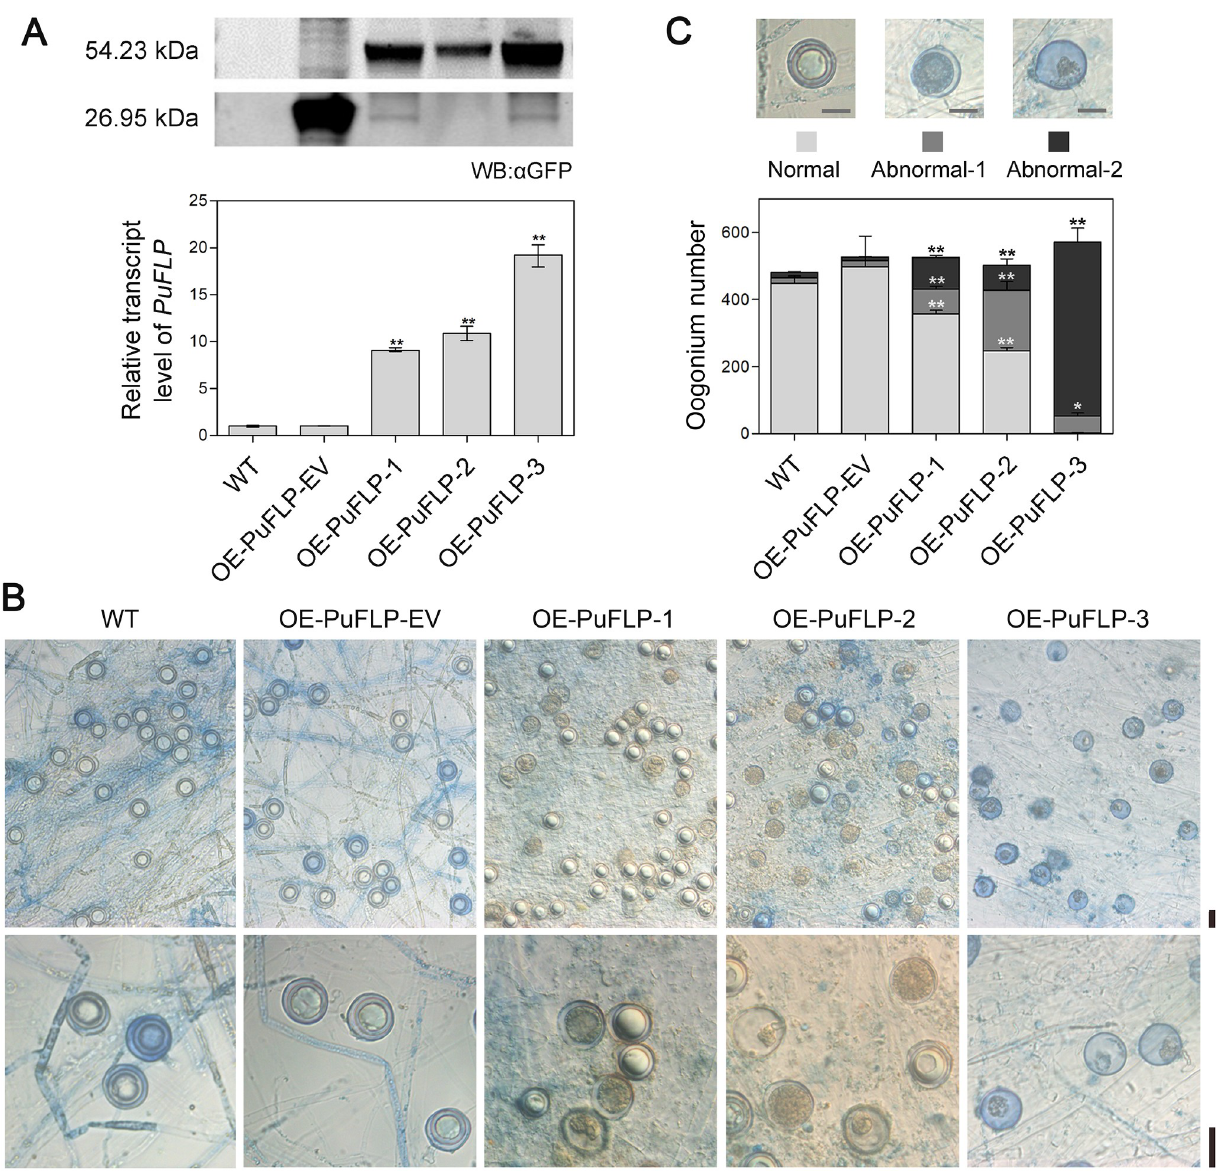
Fig 7. PuFLP overexpression affects oospore development. (A) PuFLP transcript and protein levels measured via qRT-PCR and Western blotting, respectively. Total protein was extracted from each strain for SDS-PAGE and immunoblotting was performed with GFP antibodies. Relative transcript levels were calculated using the WT as a reference. The experiments were repeated independently three times. (B) Morphology of oogonia and oospores generated in 14-day-old cultures of WT, an empty-vector control (OE-PuFLP-EV), and PuFLP overexpression transformants (OE-PuFLP-1/2/3). (C) Statistical analysis of oogonium numbers generated in 14-day-old cultures. Bar, 20 μ m. Asterisks indicate significant differences comparing with WT at P < 0.05 ( � ) or P < 0.01 ( �� ). generated abnormal oospores of types abnormal-1 and abnormal-2 and almost no normal oospores. Likely due to their lower overexpression levels, OE-PuFLP-1 and OE-PuFLP-2 gen- erated fewer abnormal oospores (abnormal-1: 13% and 33%; abnormal-2: 17% and 13%) than OE-PuFLP-3, but significantly more than the WT and OE-PuFLP-EV (Fig 7B and 7C). In addition, the transcript level of PuFLP was increased at 36 h and 48 h and then repressed at 96